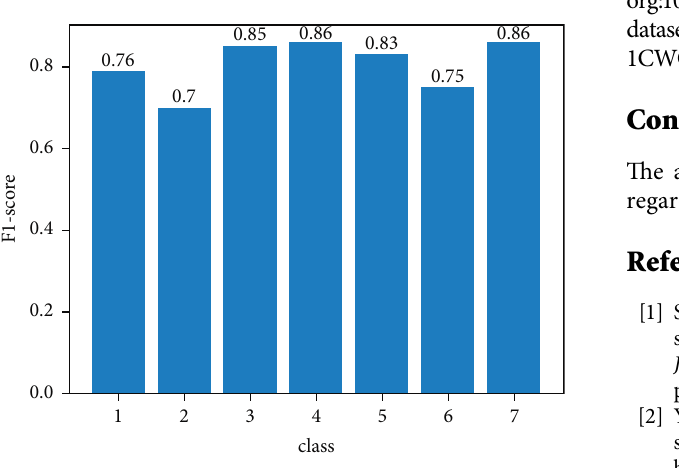
Figure 17: F 1 score of 7 classes of samples on ERNT18.